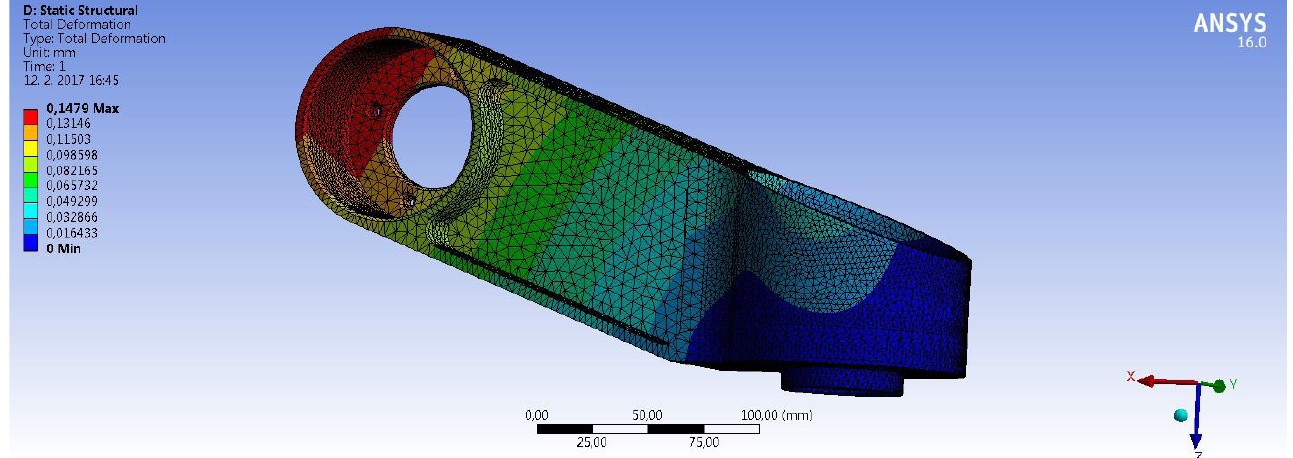
Figure 12. Size of deformation in the direction of axis Z for CvM_NcM, determined by FEM calculation, under self-weight loading.